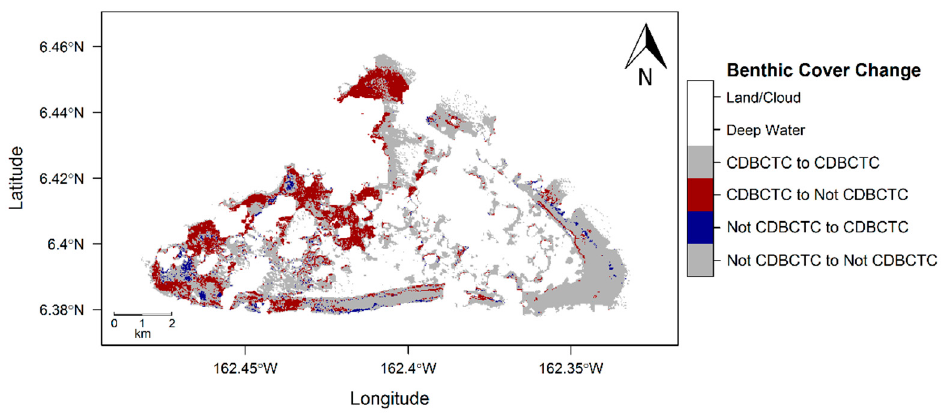
Figure 8. Difference in predicted class membership map for the Kingman Reef area of interest for 2001 initial state compared to 2015 final state.